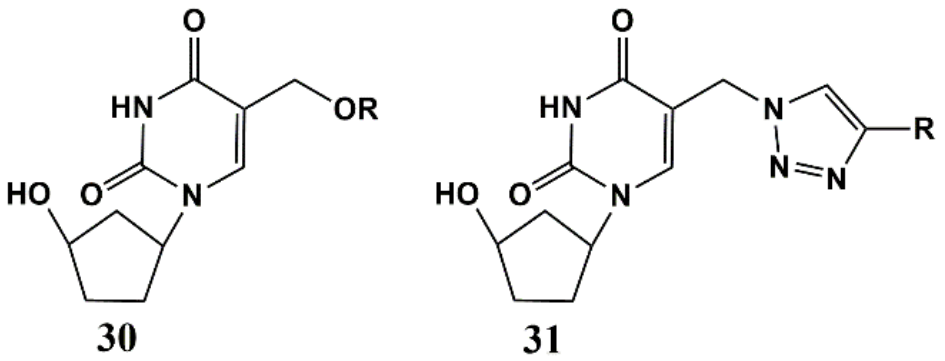
Figure 8. 5-Alkyloxymethyl and 5-alkyltriazolylmethyl substituted 5 ′ -norcarbocyclic uridine ana- logues. R: C 10 H 21 ( 30a , 31a ), C 11 H 23 ( 30b , 31b ), C 12 H 25 ( 30c , 31c ).